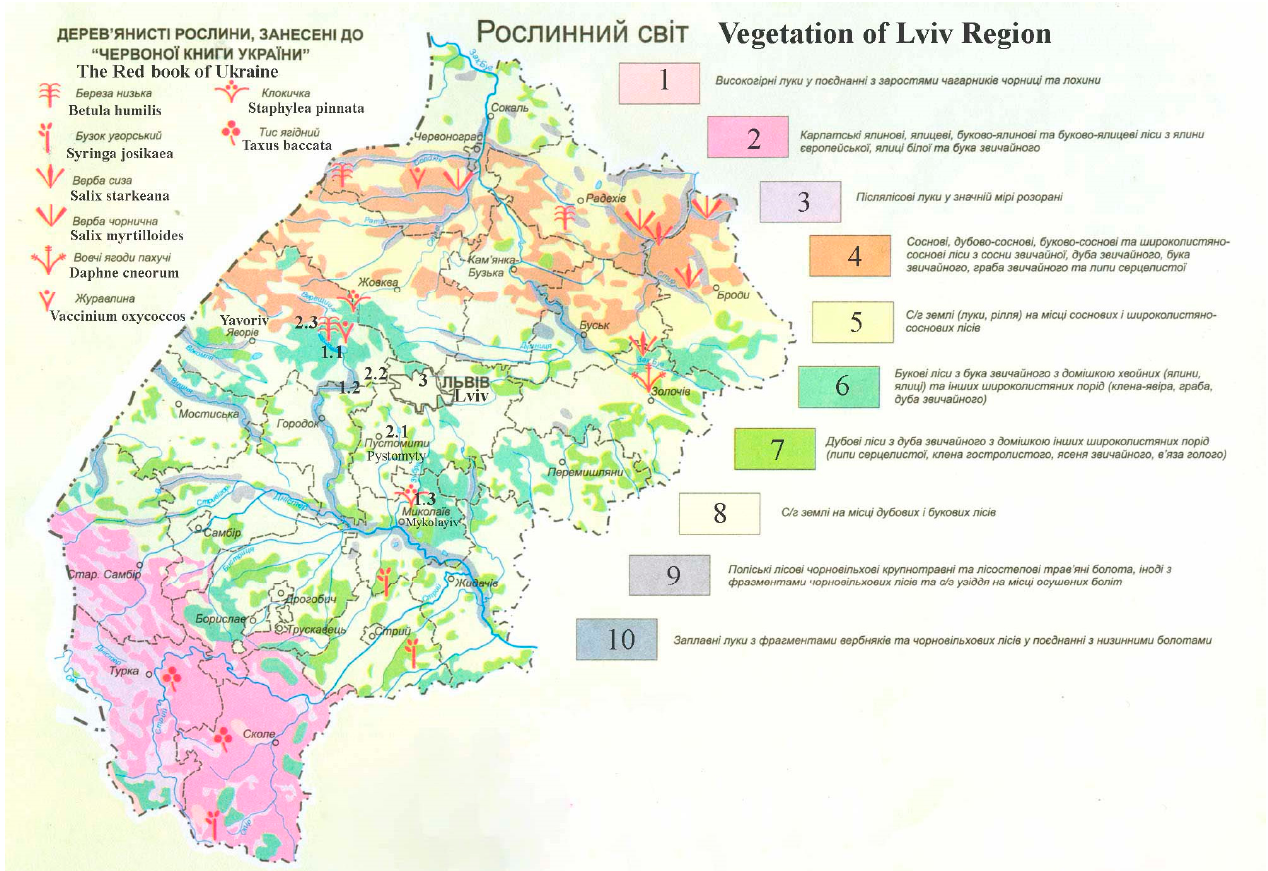
Figure 1. The distribution of species of the genus Thymus in vegetation of Lviv Region. Th. Ser- pyllum : 1.1—population No 1.1; 1.2—population No 1.2; 1.3—population No 1.3. Th. Pulegioides : 2.1—population No 2.1; 2.2—population No 2.2; 2.3—population No 2.3. Th. Marschallianus : 3—population No 3. Legend: High-altitude meadows combined with thickets of huckleberries and blueberry bushes. Carpathian spruce, fir, beech–spruce, and beech–fir forests from European spruce, white fir, and ordinary beech. Post-forest meadows are largely plowed. Pine, oak–pine, beech–pine, and broadleaf-pine forests of ordinary pine, ordinary oak, or- dinary beech, ordinary hornbeam, and heart-leaved linden. Agricultural land (meadow, arable land) in the place of pine and broadleaf-pine forests. Beech forests from ordinary beech with an admixture of conifers (spruce and fir) and other broad-leaved species (sycamore maple, hornbeam, and ordinary oak) . Oak forests from ordinary oak with admixture of other broad-leaved species (heart- leaved linden, sharp-leaf maple, ordinary ash, and bare elm) . Agri- cultural land in the place of oak and beech forests. Polissja forest of black alder coarse-grass and forest-steppe grass swamps, sometimes with fragments of black alder forests and agricultural land in place of drained swamps. Flood- nation with lowland swamps.